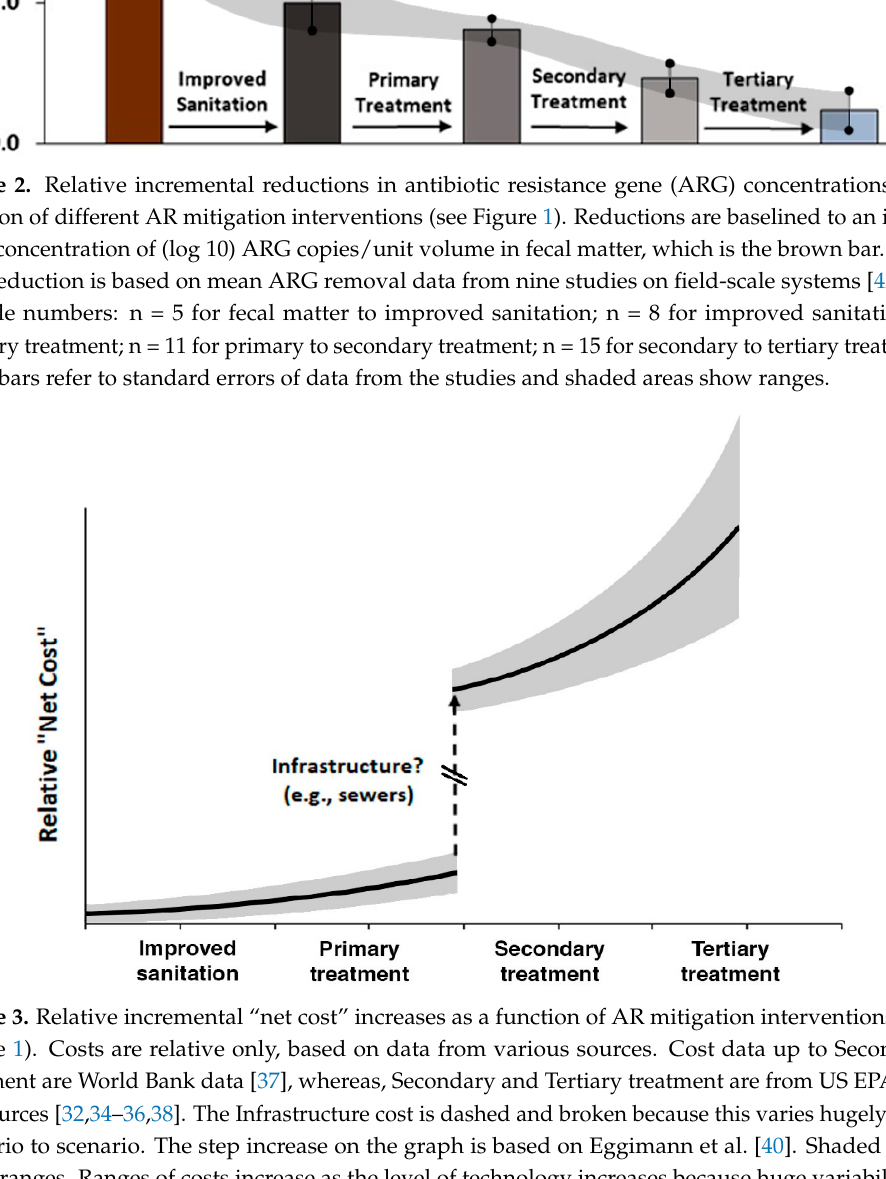
Figure 1). Costs are relative only, based on data from various sources. Cost data up to Secondary treatment are World Bank data [37], whereas, Secondary and Tertiary treatment are from US EPA and EU sources [32,34–36,38]. The Infrastructure cost is dashed and broken because this varies hugely from scenario to scenario. The step increase on the graph is based on Eggimann et al. [40]. Shaded areas show ranges. Ranges of costs increase as the level of technology increases because huge variability in technical options exists (and their costs), within the secondary and tertiary treatment